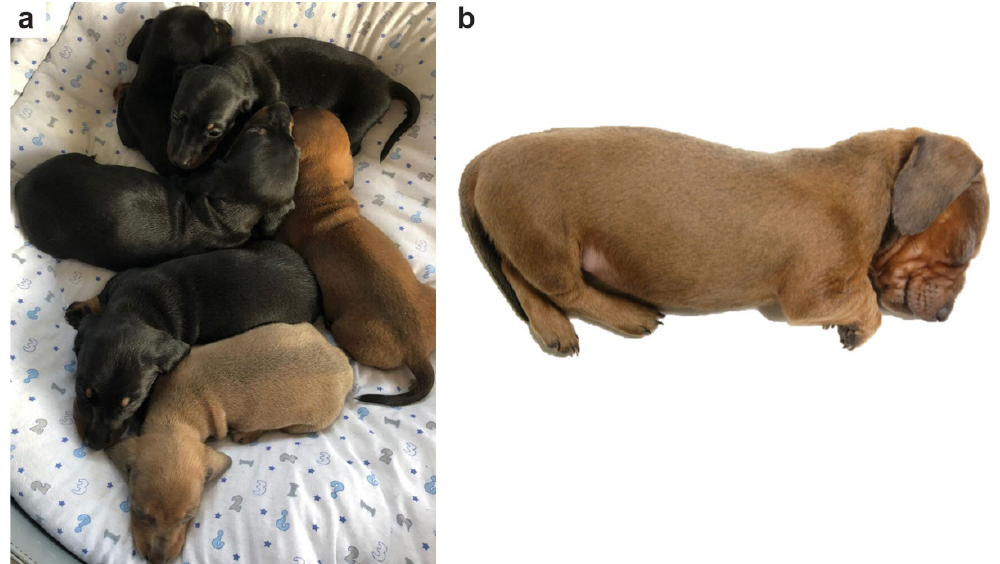
Figure 1. Coat color dilution phenotype. ( a ) The photo shows the entire litter consisting of six puppies. Four of the non-affected puppies had black and tan coat colors. The affected puppy at the bottom of the photo had a dilute red color, which is much lighter than the standard red color of its non-affected sibling on the right. ( b ) Larger photo from the affected puppy alone.